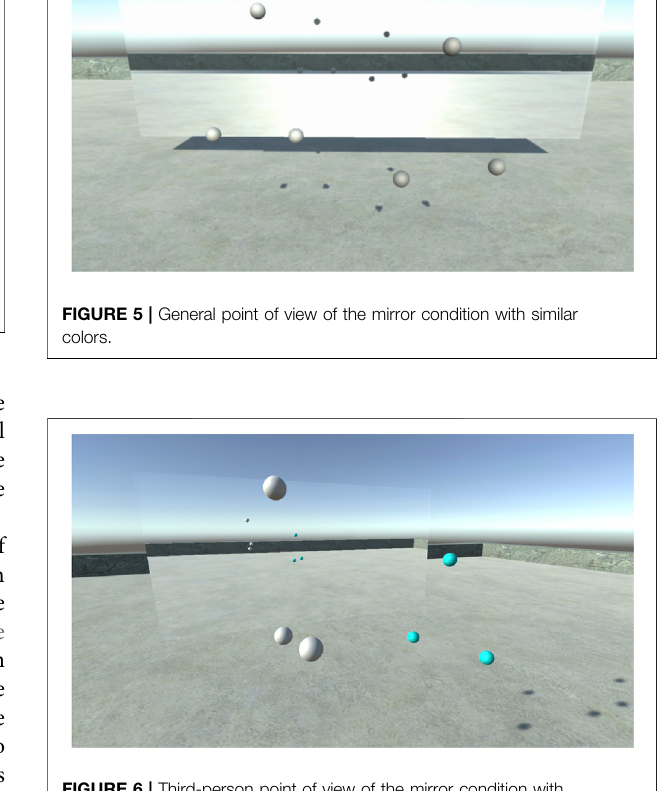
FIGURE 6 | Third-person point of view of the mirror condition with different